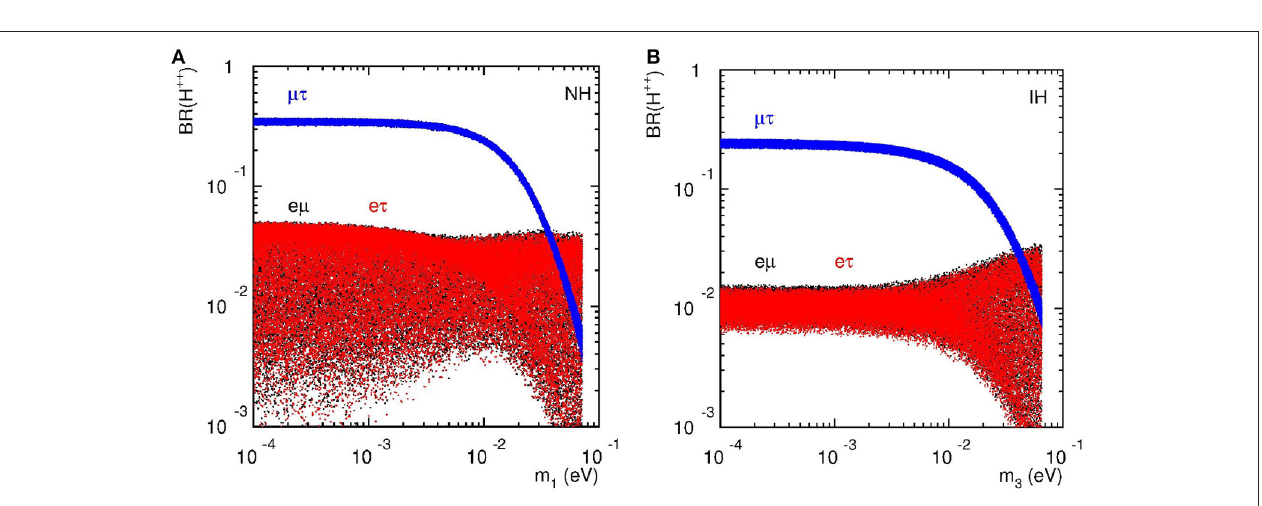
FIGURE 26 | H ++ decay to the flavor-off-diagonal like-sign dileptons vs. the lowest neutrino mass for NH (A) and IH (B) with 8 1